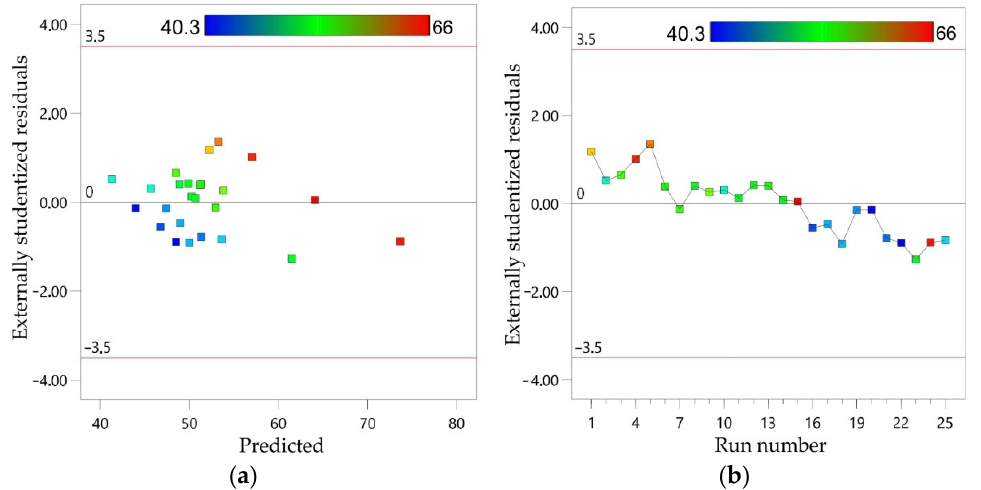
Figure 12. Externally studentized residuals with reference to: ( a ) predicted and ( b ) run number for